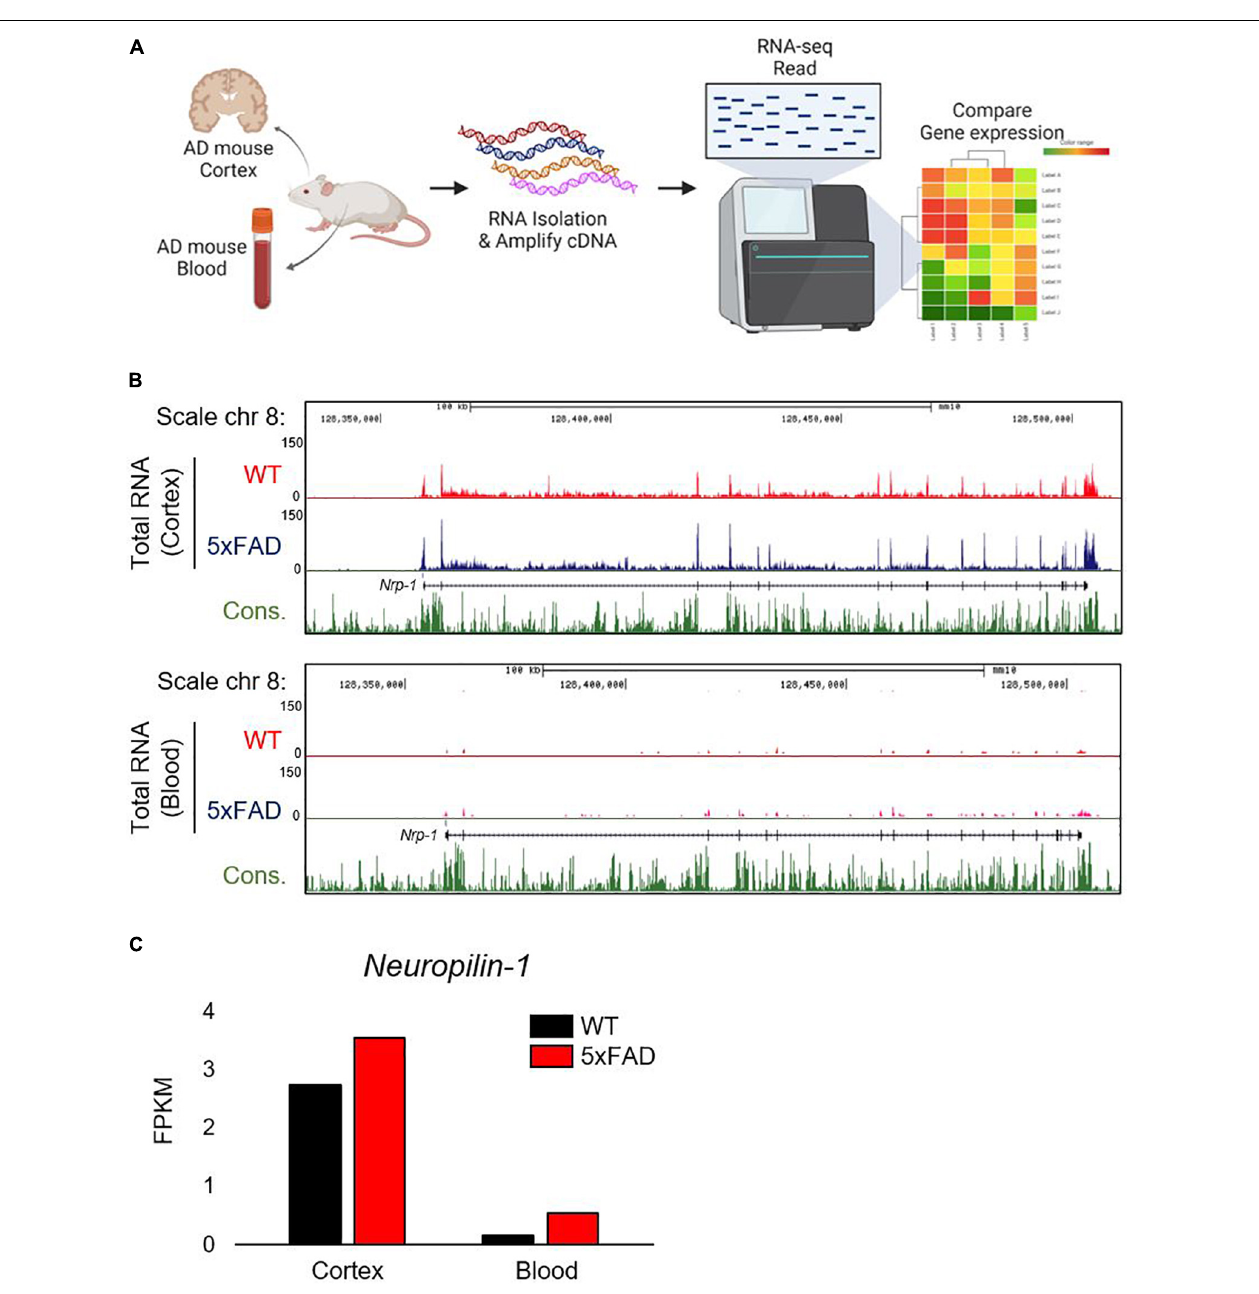
FIGURE 1 | Correlation between Nrp1 gene and protein expression in AD brain. (A) Graphic representation of Nrp1 gene expression in the cortex of five familial AD mutations (5 × FAD) mice, which are used as a murine model of AD. (B) The representation is shown on the UCSC genome browser following total RNA-seq. (C) Nrp1 gene expression levels are increased by 129% in 5 × FAD cortex compared with control WT cortex.